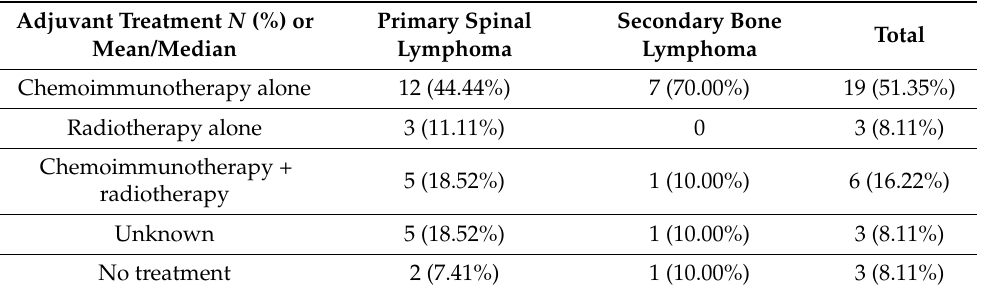
Table 4. Adjuvant therapy divided according to the primary spinal lymphoma and secondary bone lymphoma.